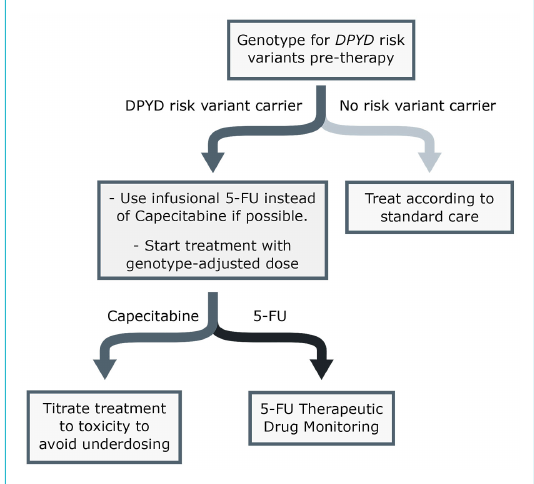
Figure 1: Simplified scheme for fluoropyrimidine dosing. 5-FU = 5-fluorouracil.